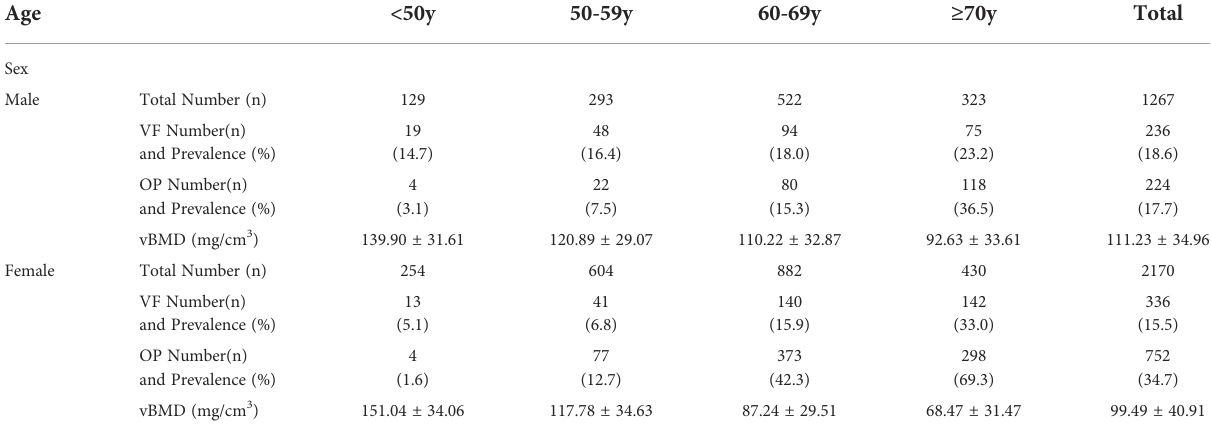
TABLE 1 The prevalence of vertebral fractures (VFs), osteoporosis (OP) and the mean ± standard deviation of vBMD by gender and age